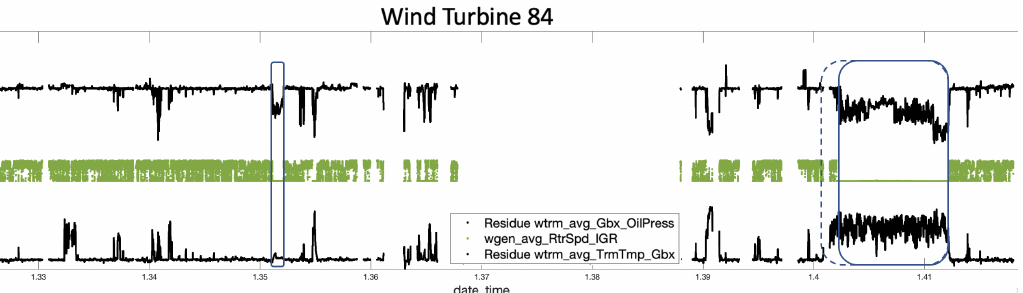
Figure 16. Analysis of the WT83 turbine on the basis of the residues obtained from the signals wtrm_avg_Gbx_OilPress (upper signal, in black) and wtrm_avg_TrmTmp_Gbx (lower signal, in black) together with the rotation of the rotor of the WT83 turbine (central part, in blue). The blue rectangles identify peaks in the residual signals that coincide with turbine stops, detected as zero-valued angular velocities. The red rectangle shows a ghost peak.